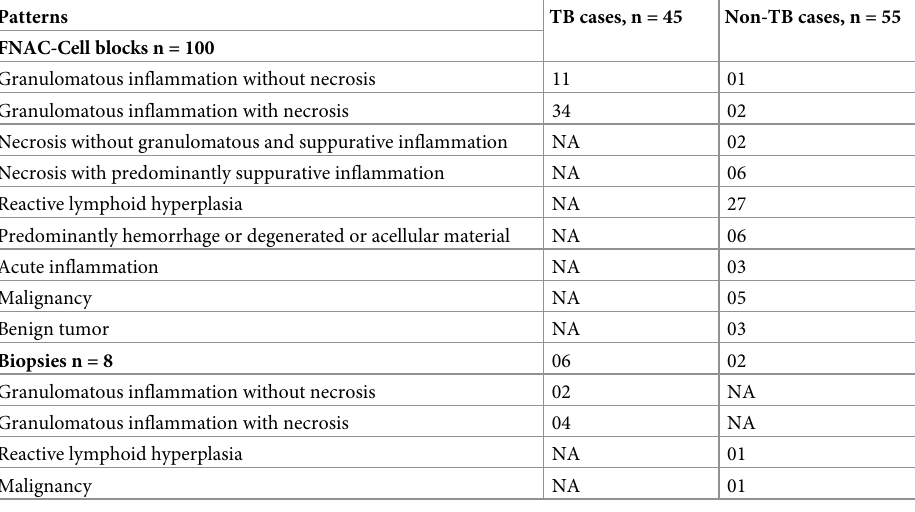
Table 2. The pattern of cytology findings among TB and non-TB cases. Patterns TB cases, n = 45 Non-TB cases, n = 55 FNAC-Cell blocks n = 100 Granulomatous inflammation without necrosis 11 01 Granulomatous inflammation with necrosis 34 02 Necrosis without granulomatous and suppurative inflammation NA 02 Necrosis with predominantly suppurative inflammation NA 06 Reactive lymphoid hyperplasia NA 27 Predominantly hemorrhage or degenerated or acellular material NA 06 Acute inflammation NA 03 Malignancy NA 05 Benign tumor NA 03 Biopsies n = 8 06 02 Granulomatous inflammation without necrosis 02 NA Granulomatous inflammation with necrosis 04 NA Reactive lymphoid hyperplasia NA 01 Malignancy NA 01 Note . FNAC, fine-needle aspiration cytology; TB, tuberculosis, NA =